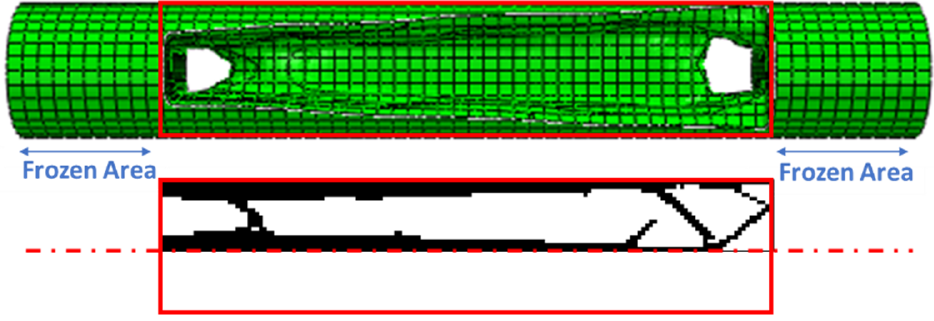
Figure 12. The comparison of the results obtained from ABAQUS software and MATLAB code for the rectangular plane. (Note: The red doed line is the axisymmetric line for the sample.)